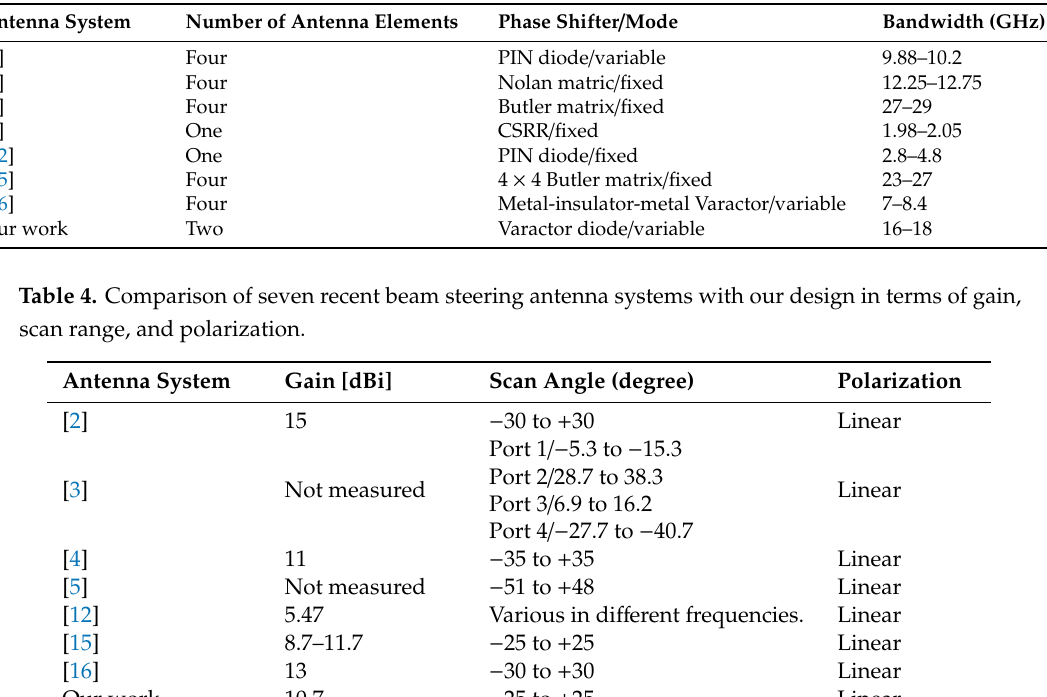
Figure 18. 50° scan range provided by changing the biasing voltage of the varactor diodes from 0 V to 20 V. Table 3. Comparison of seven recent beam steering antenna systems with our design in terms of phase shifter type, bandwidth, and number of elements.